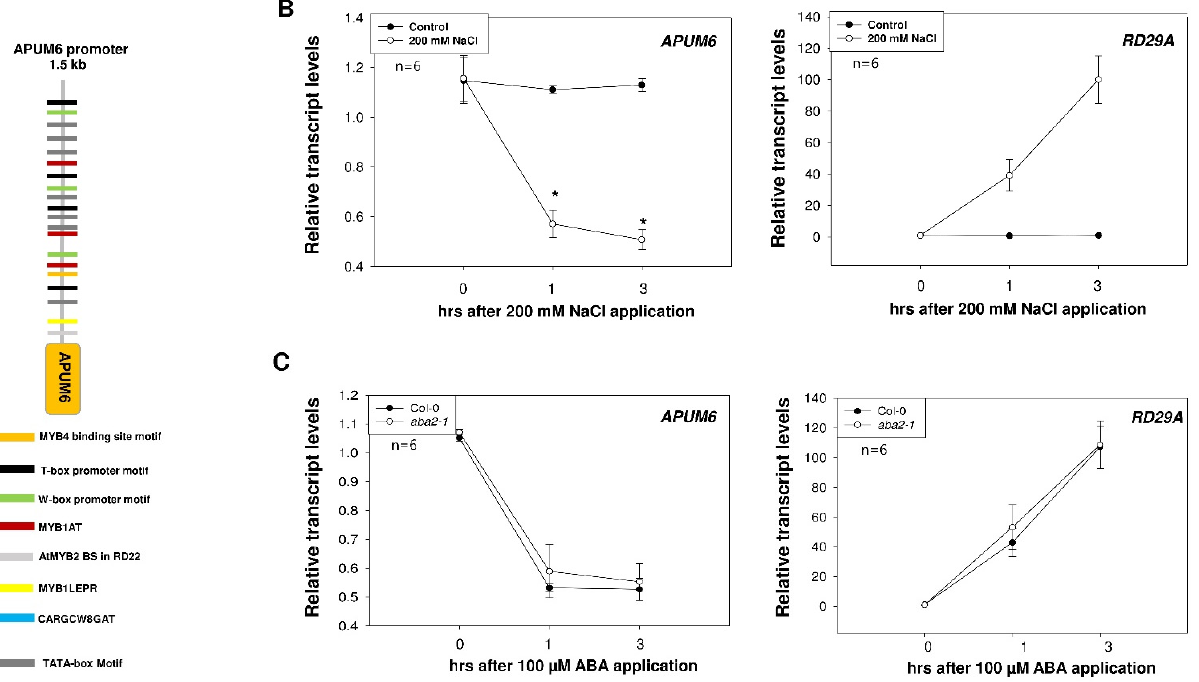
Figure 3. Expression patterns of APUM6 upon salt and ABA treatments. ( A ) Promoter of APUM6 analysis via PlantCARE. APUM6 promoter contained the MYB-related binding motif, WRKY-binding motif, and T-box motif. ( B ) Expression of APUM6 in response to salt stress. The expression patterns of APUM6 after the 200 mM NaCl treatment in the leaves by qRT-PCR with specific primers as shown in Supplementary Table S1. Transcript levels were normalized to Actin . RD29A was used as a positive control. Error bars indicate SD ( n = 6). Asterisks indicate significant differences from the control using the unpaired Student’s t -test (* p < 0.05). ( C ) Expression of APUM6 in response to ABA. The expression patterns of APUM6 after 100 µM ABA treatment in the 4-week-old Col-0 and ABA-deficient aba2-1 mutant background leaves by qRT-PCR. Transcript levels were normalized to Actin . RD29A was used as a positive control. Error bars indicate SD ( n = 6).